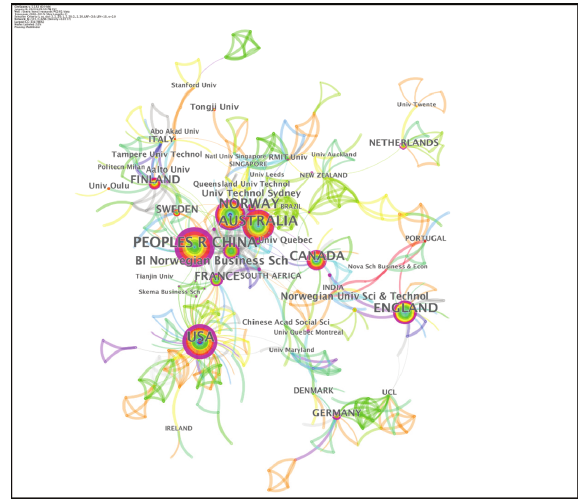
Figure 4: Network of countries/regions and institutions in project governance